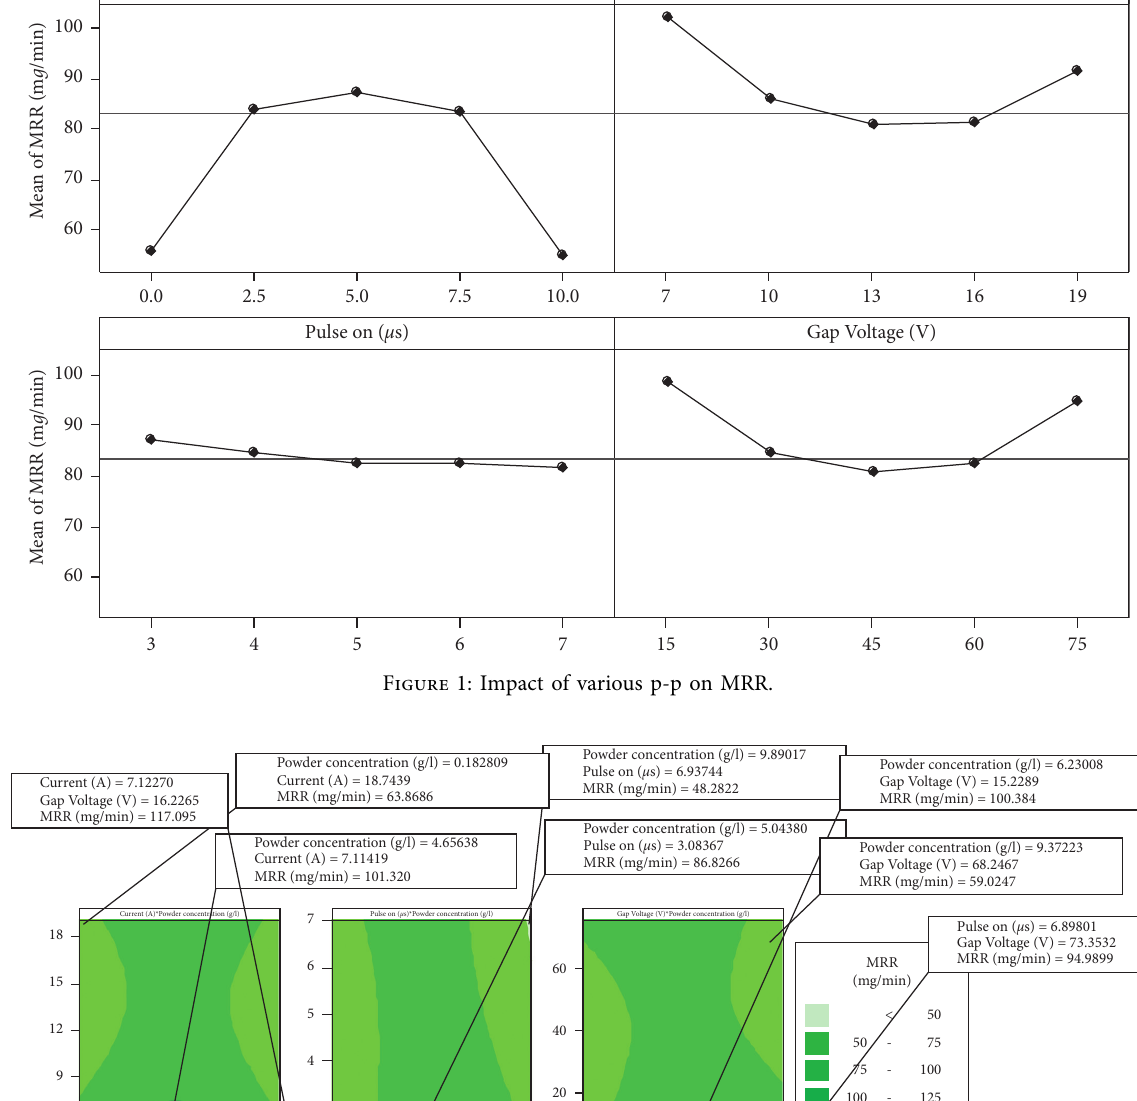
Figure 2: Interaction plot impact of distinct input variables vs. MRR of AA2024/5Al